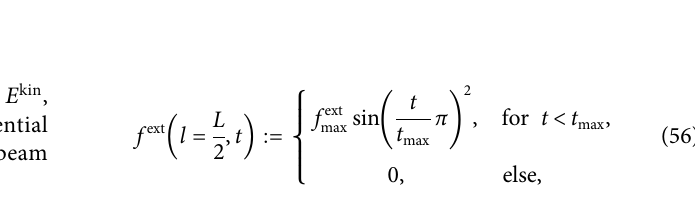
FIGURE 5 | Energy conservation during an FEM simulation of the dynamic curve tangent angle model in a clamped-free scenario, where an external torque is applied tothecenterofaninitiallystraightbeamfor0.5 s.Theleftplotshowstheenergydistribution.Therightplotshowstheenergyalongthebeamatasnapshottaken at t (cid:2) 1